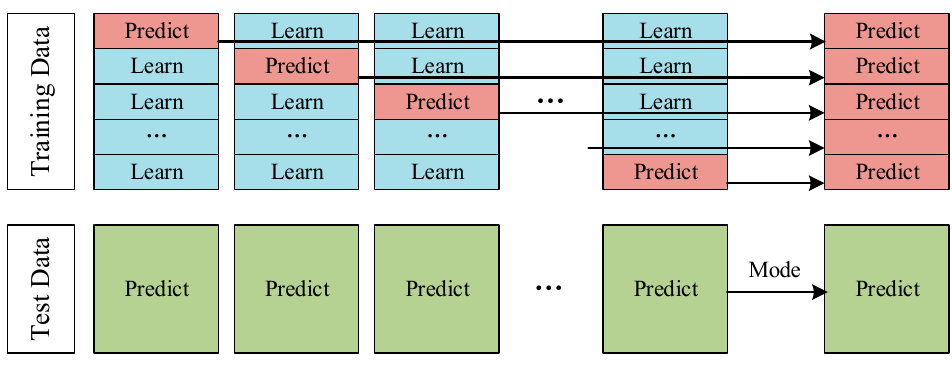
Figure 5. 10-fold cross-validation.